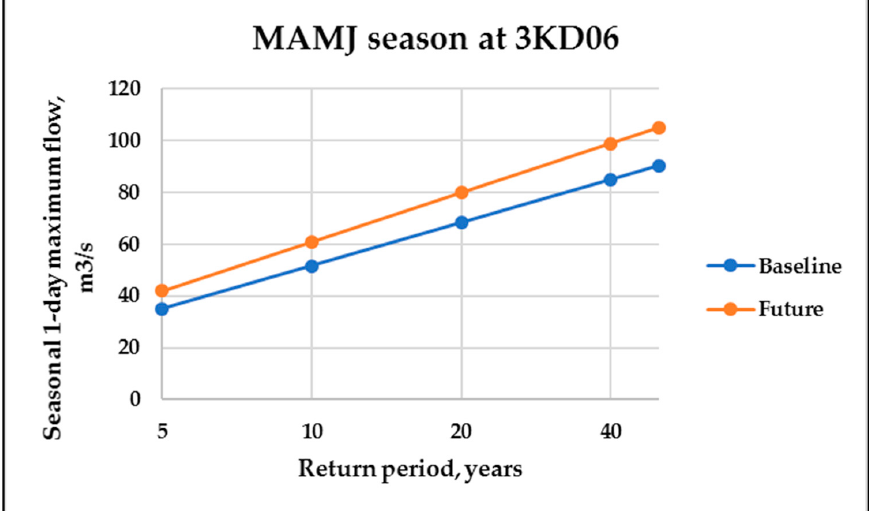
Figure 12. Return periods comparison of the maximum one day flow for MAMJ season.